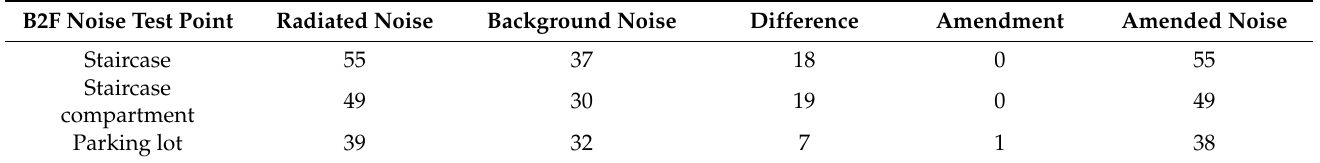
Table 5. Amended results of L Aeq in the B2F noise test points (dB (A)). B2F Noise Test